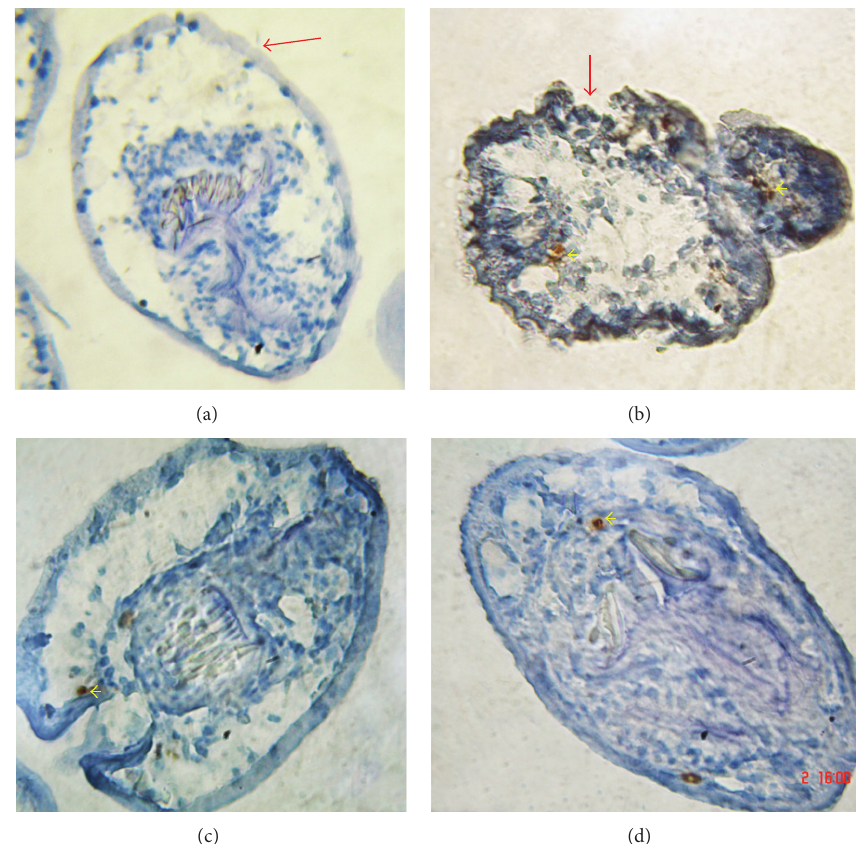
Figure 8: Light micrographs of TUNEL staining of E. granulosus protoscoleces incubated in vitro with thymol and essential oils of T. vulgaris and O. vulgare . (a) Invaginated control protoscolex (16 hours p.i., 1280x). Note the integrity of the tegument (red arrow). (b)–(d) Protoscoleces showing TUNEL-positive nuclei (yellow arrowheads). (b) Evaginated protoscolex (thymol, 8 h p.i., 1700x). Note the presence of numerous apoptotic nuclei and the loss of the integrity of the tegument (red arrow). (c) Invaginated protoscolex with the presence of few TUNEL- positive nuclei ( T. vulgaris , 16h p.i., × 1500). (d) Protoscolex incubated with O. vulgare during 16 h ( × 1500). Few TUNEL-positive nuclei could be